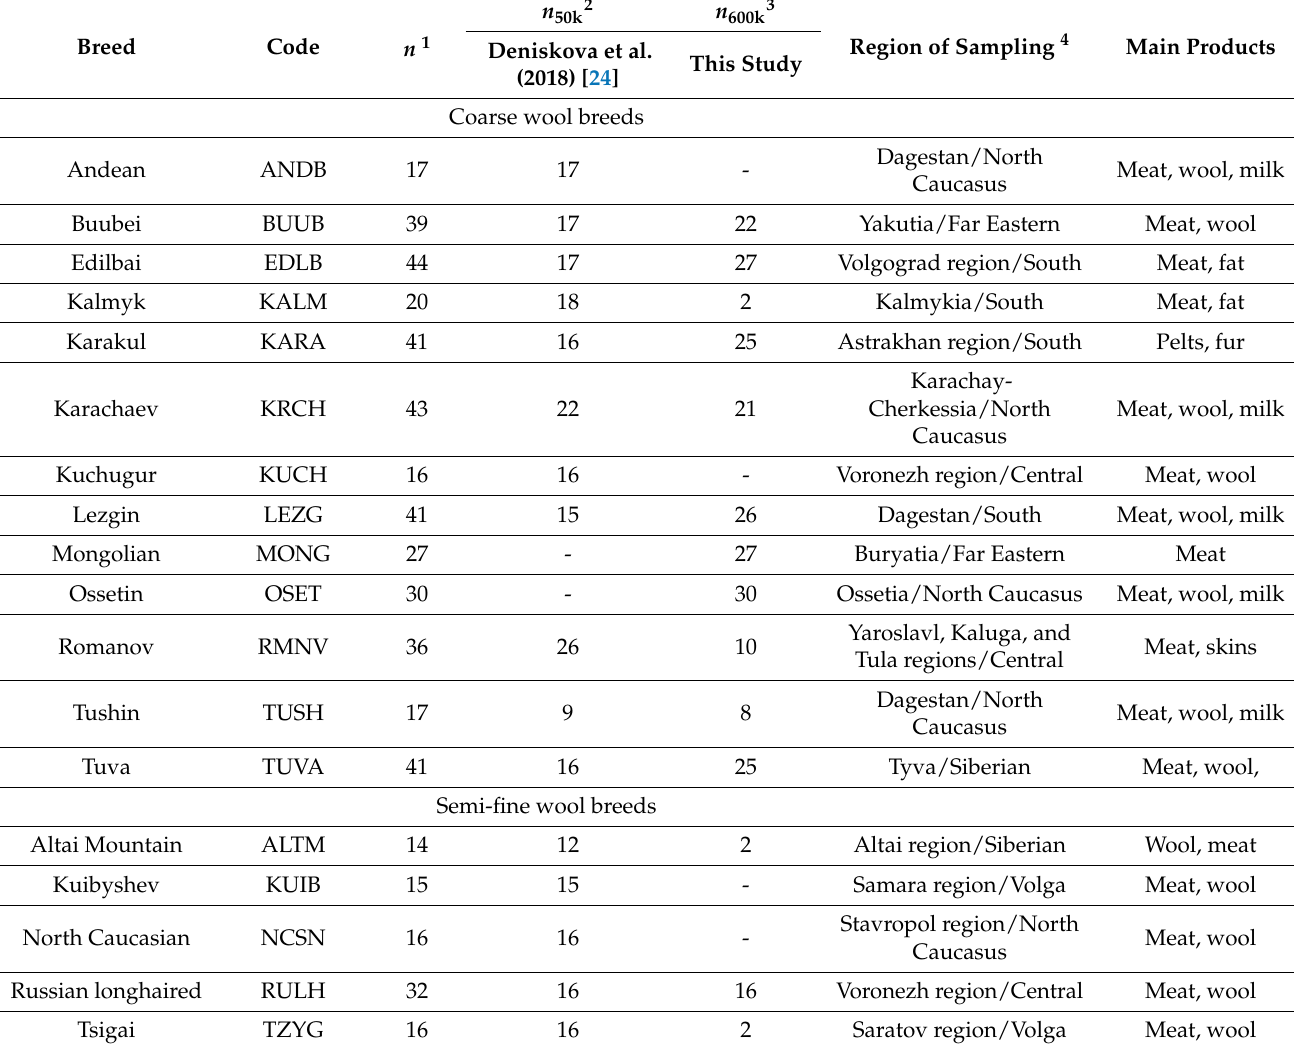
Table 1. Sample collection of Russian sheep populations used in this